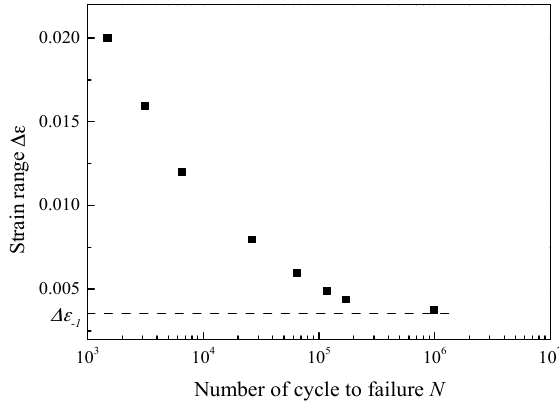
Figure 7. Fatigue life curve of 316 stainless steel.